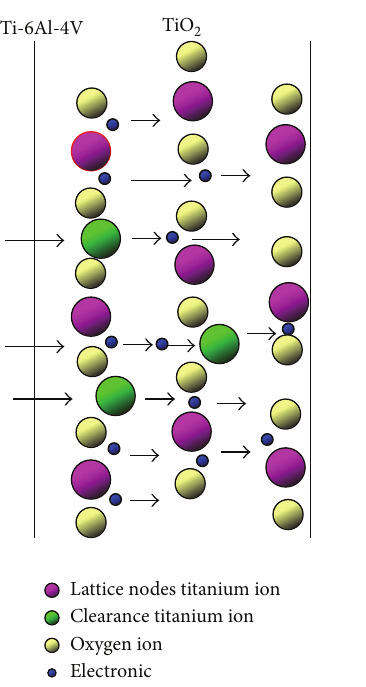
Figure 8: Schematic of the diffusion of the excessive titanium ions and electrons in the TiO 2